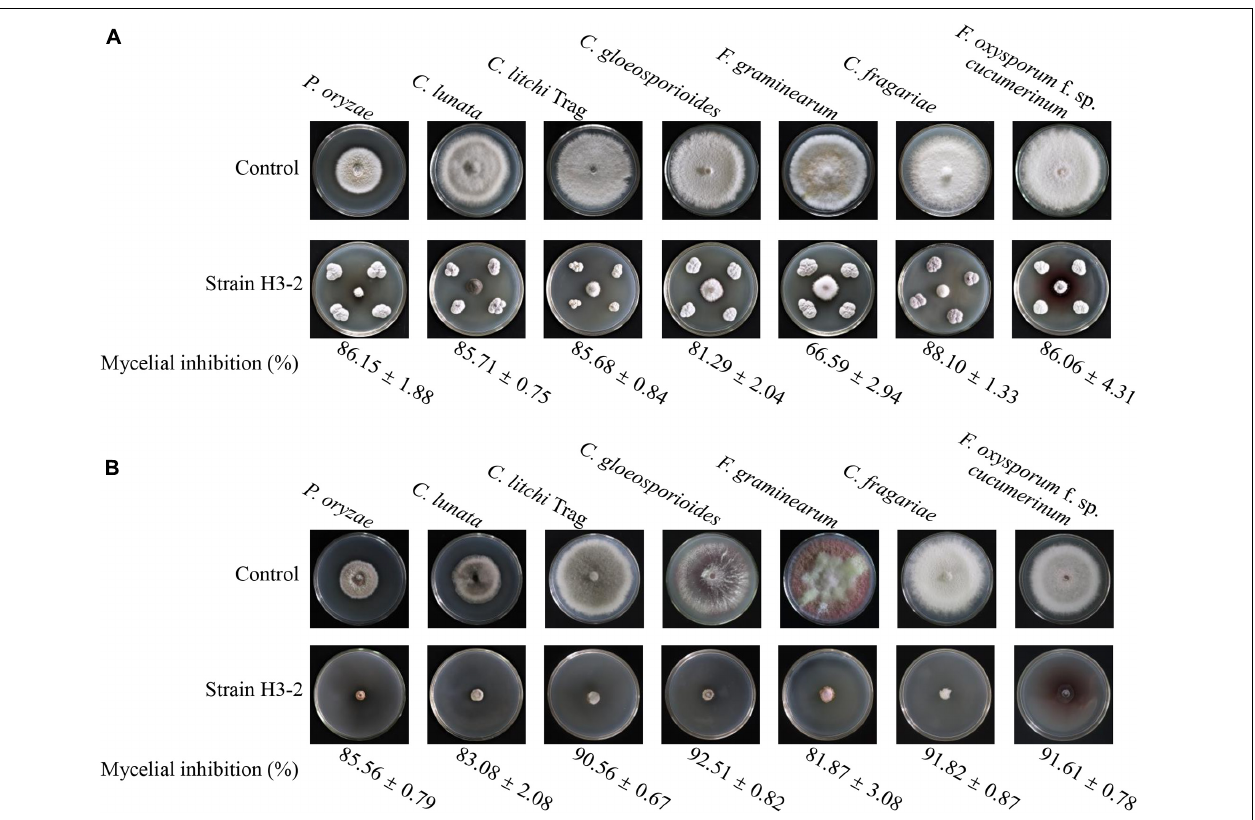
FIGURE 7 | A broad-spectrum antifungal activity of strain H3-2 (A) and its extracts (B) against the selected seven plant pathogenic fungi.